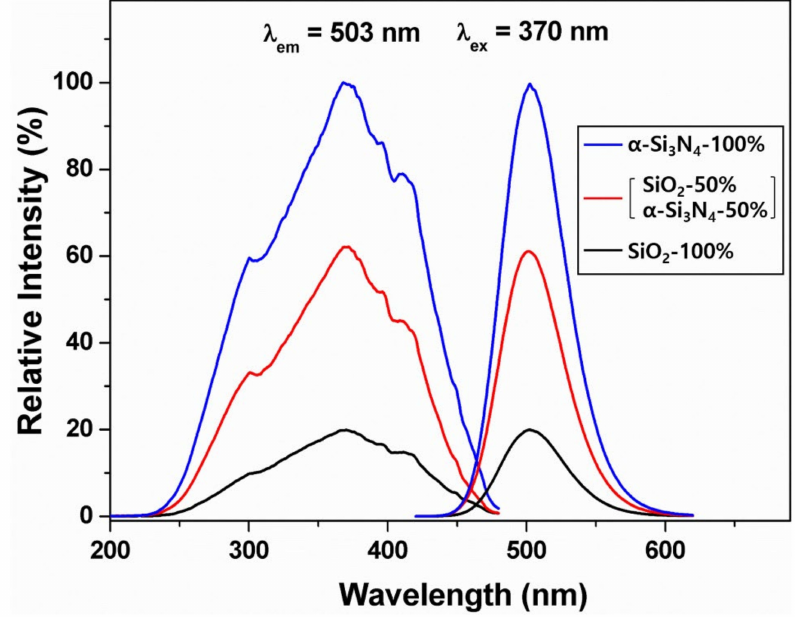
Figure 9. PL spectra of BSON:Eu 2 +